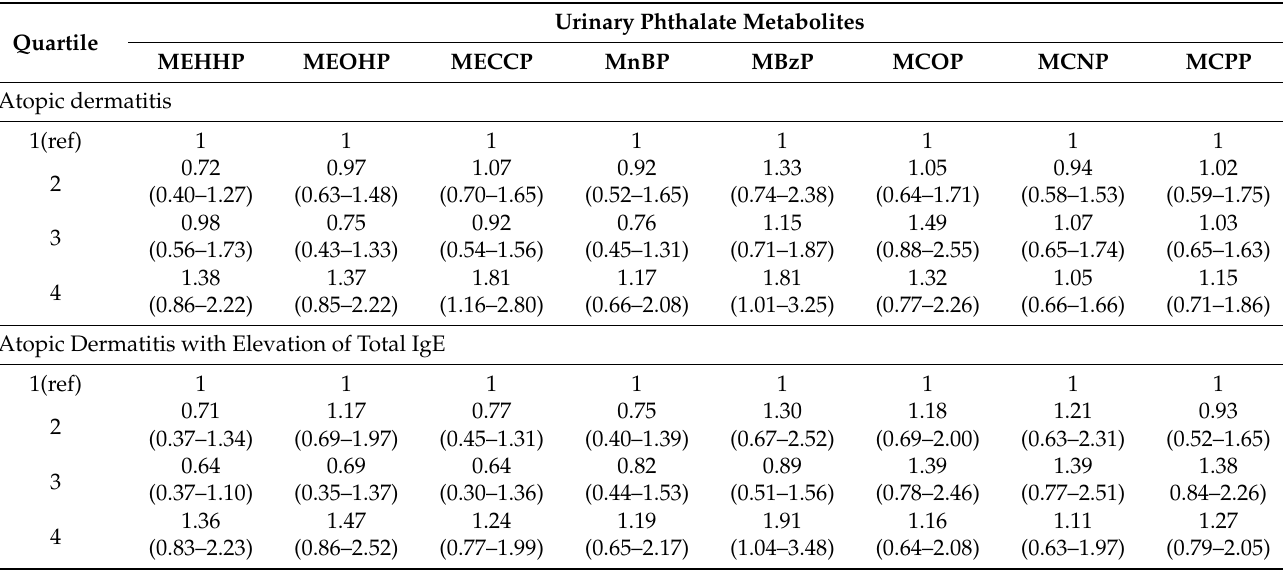
Table 5. Association (OR (95% CI)) between urinary concentration of phthalate metabolites and atopic dermatitis according to the presence of elevation of total IgE (multivariate